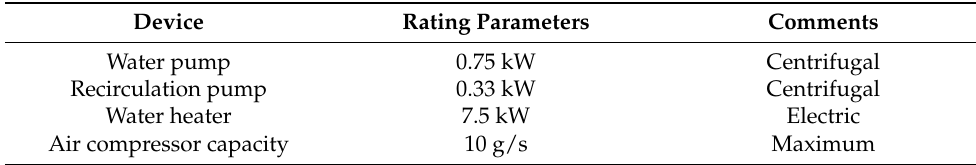
Table 2. The equipment in the test rig of the TPG